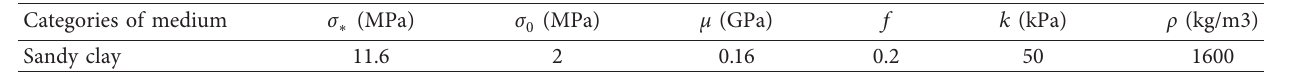
Table 2: Characteristic parameters of sandy clay.